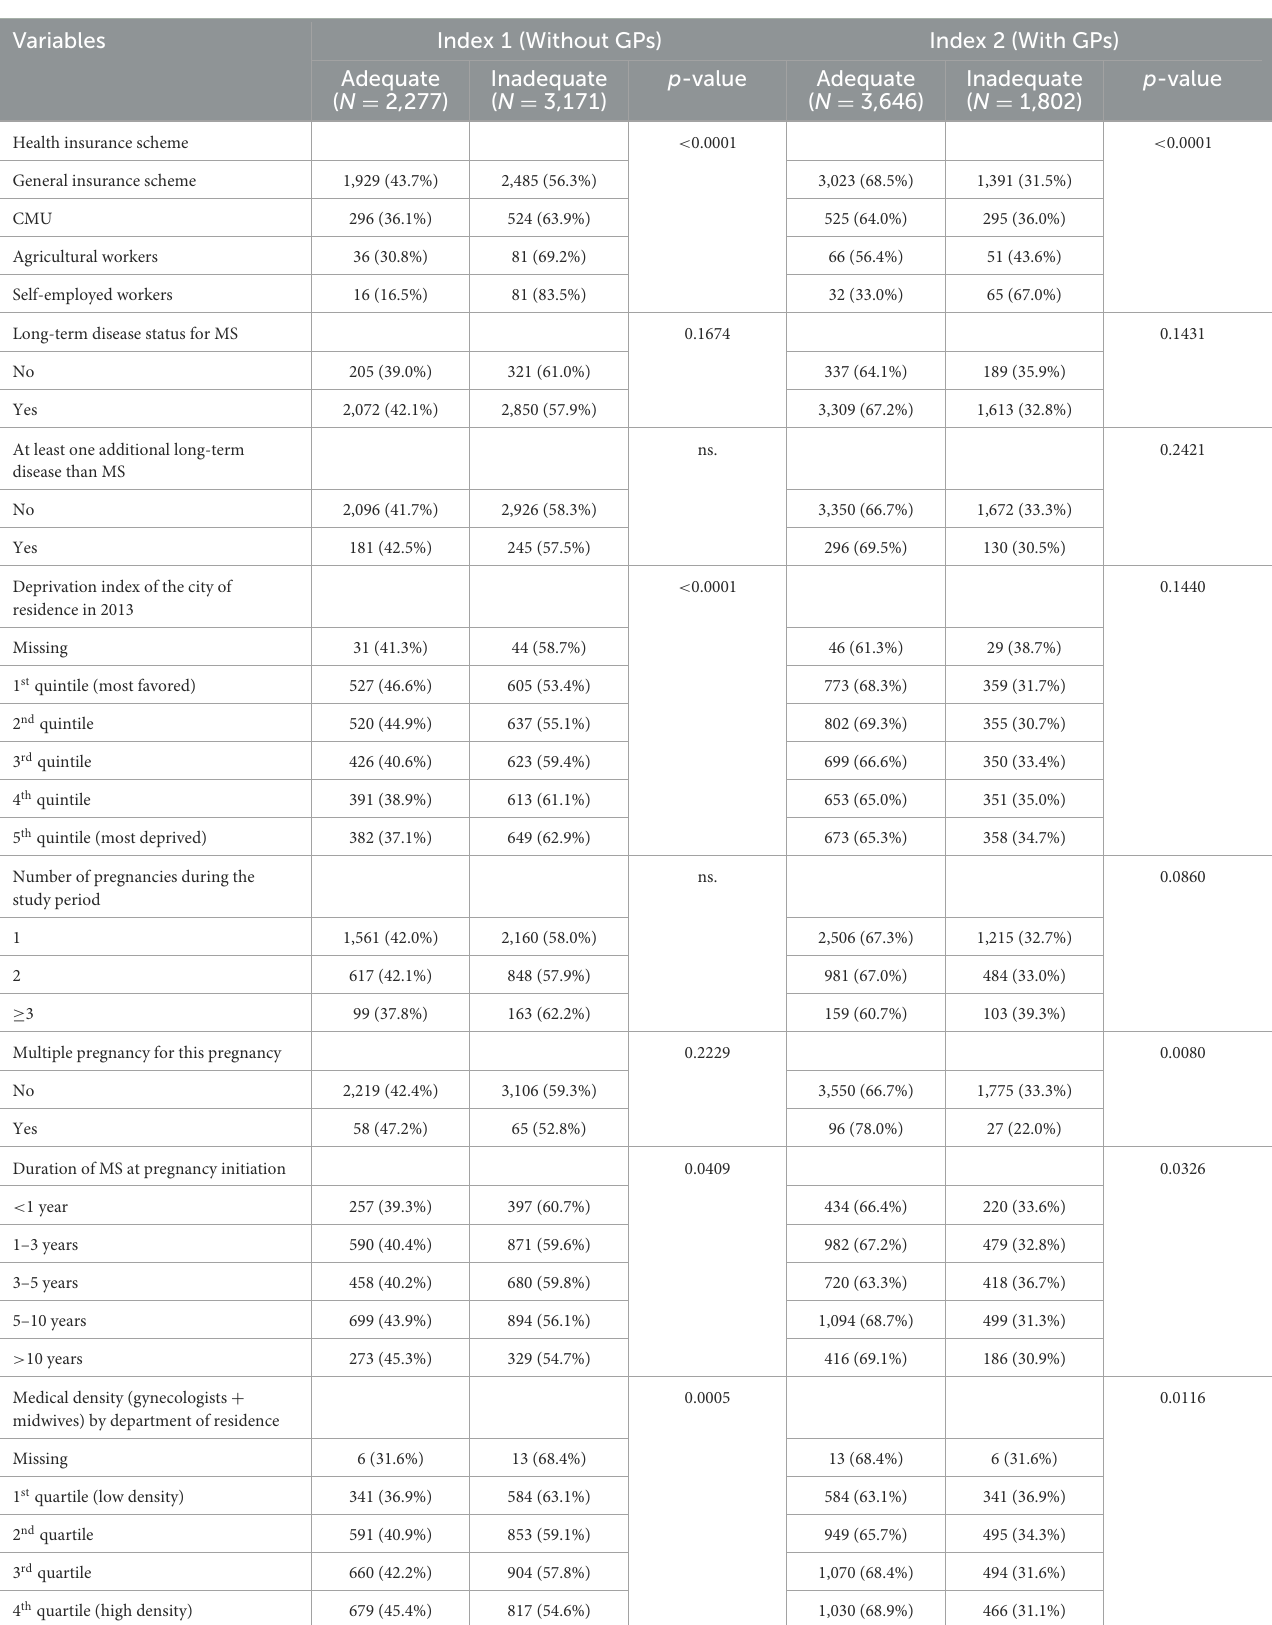
TABLE 2 Results of the univariate analysis to select variables of interest for the logistic regression